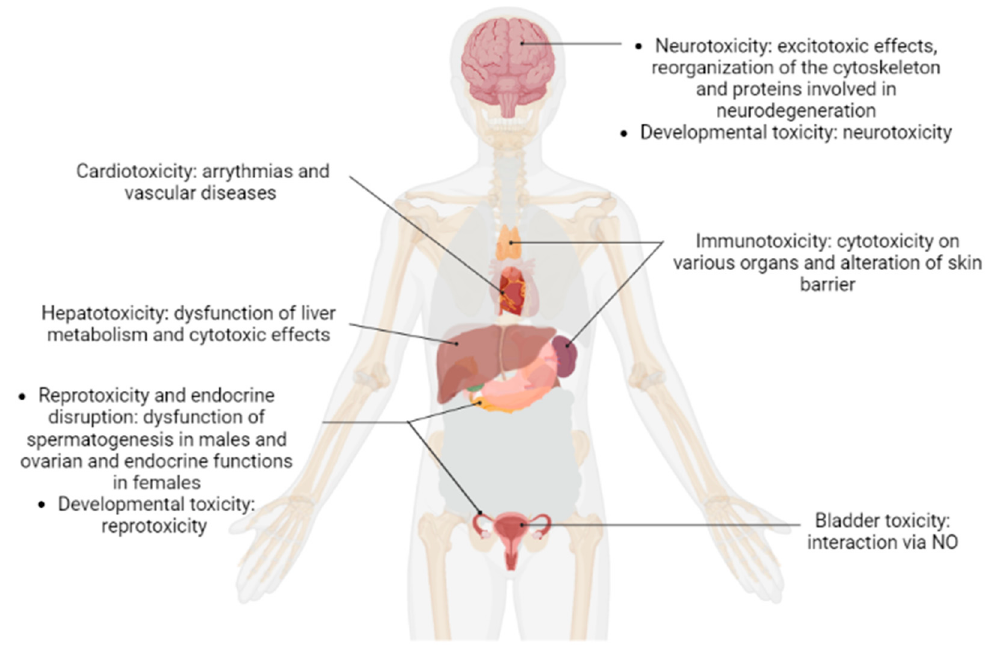
Figure 4. Summary of human toxicity induced by POPs based on proteomic studies.